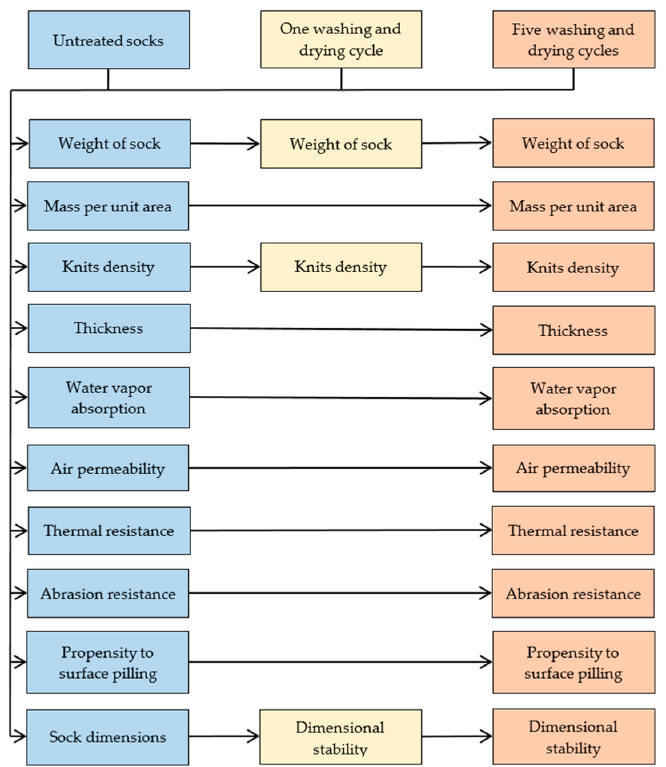
Figure 4. Schematic view of the sock quality evaluation methodology that includes the selected performance